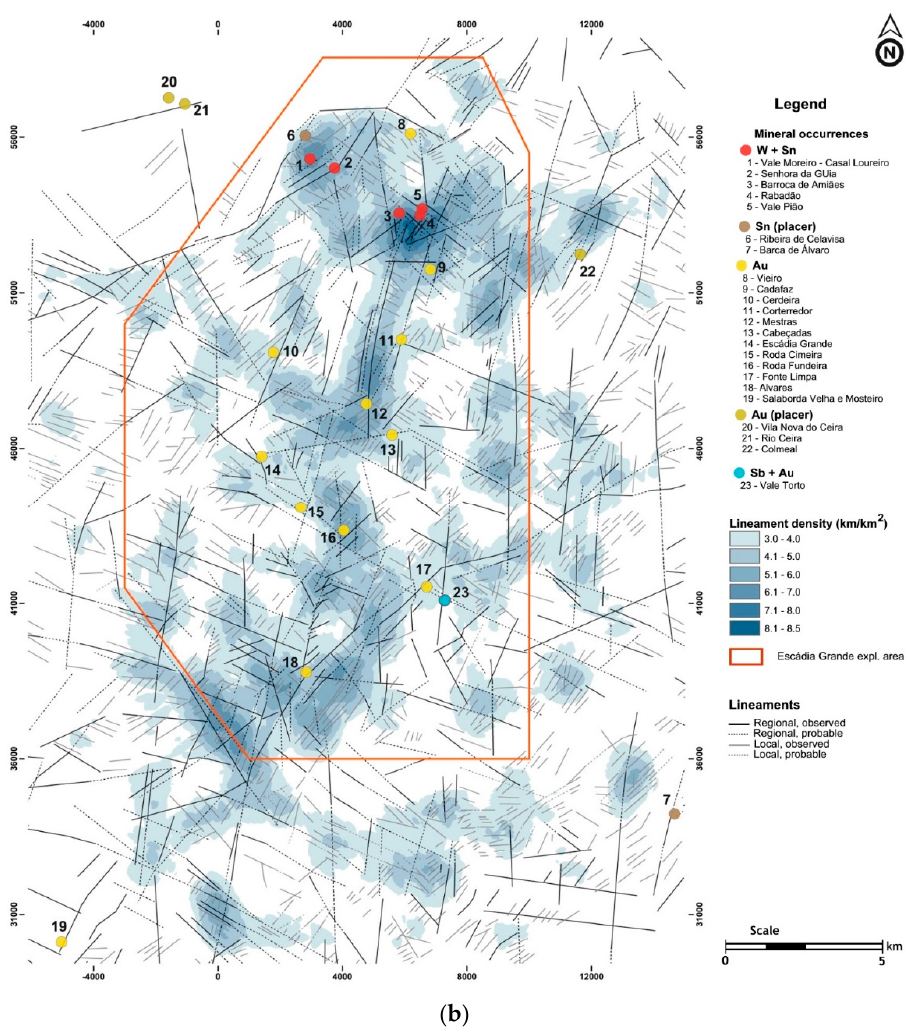
Figure 19. ( a ) Radiometric data and known mineral occurrences; ( b ) lineament density map known mineral occurrences.